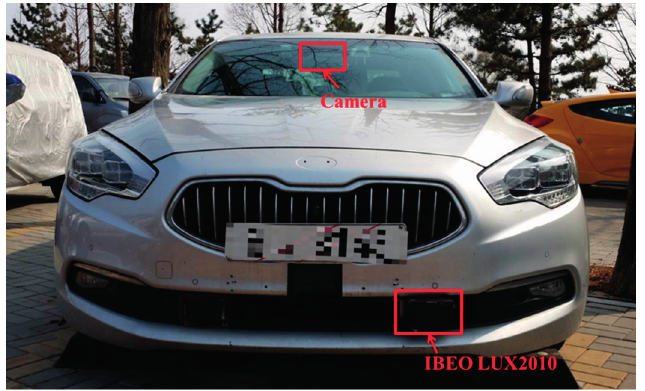
Figure 10. Vehicle and laser scanner for the